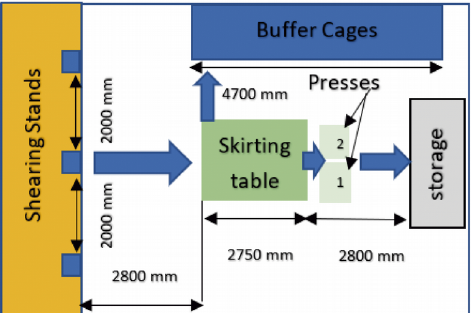
Figure 3. Shed layout overview diagram for the visited shed indicating the four main process areas: shearing stands, skirting tables and presses, buffer cages and final product storage. Workers transport the wool between stages, blue arrows represent fleece movements.